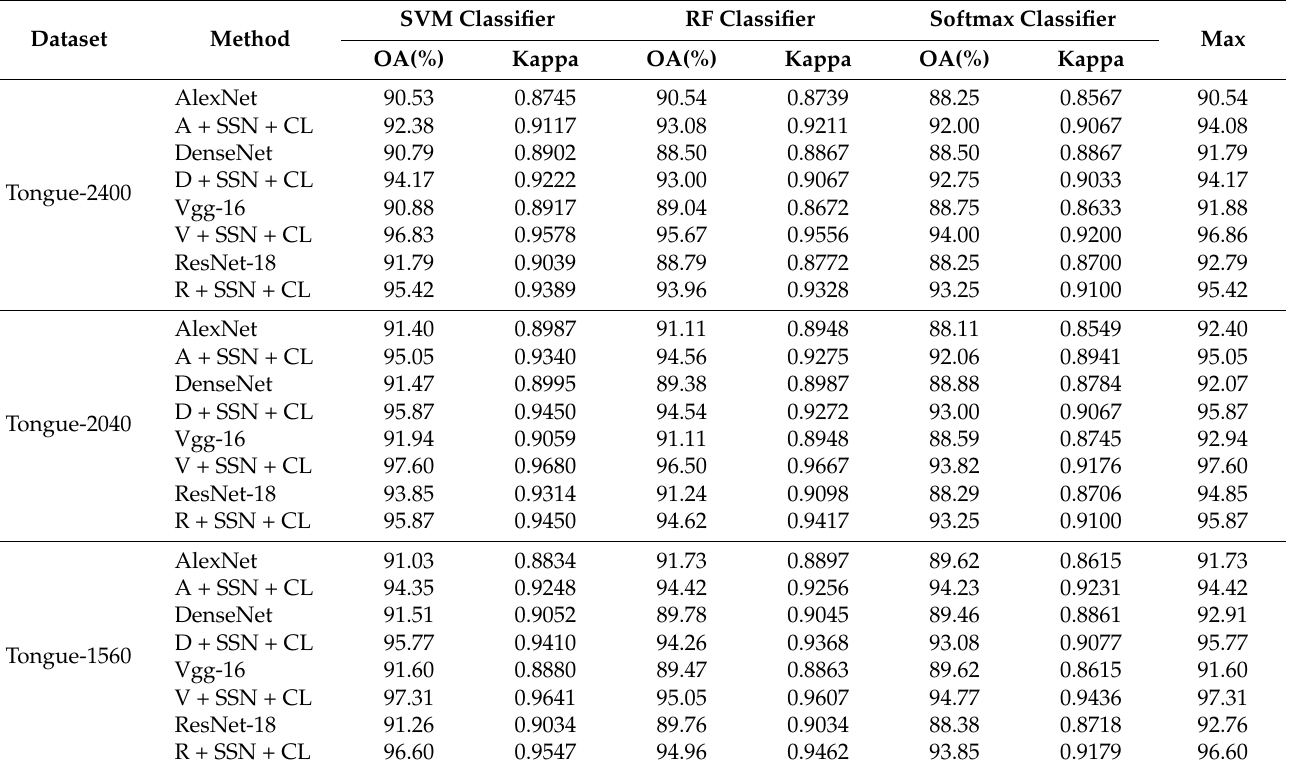
Table 2. Best mean Overall Accuracy comparison of different